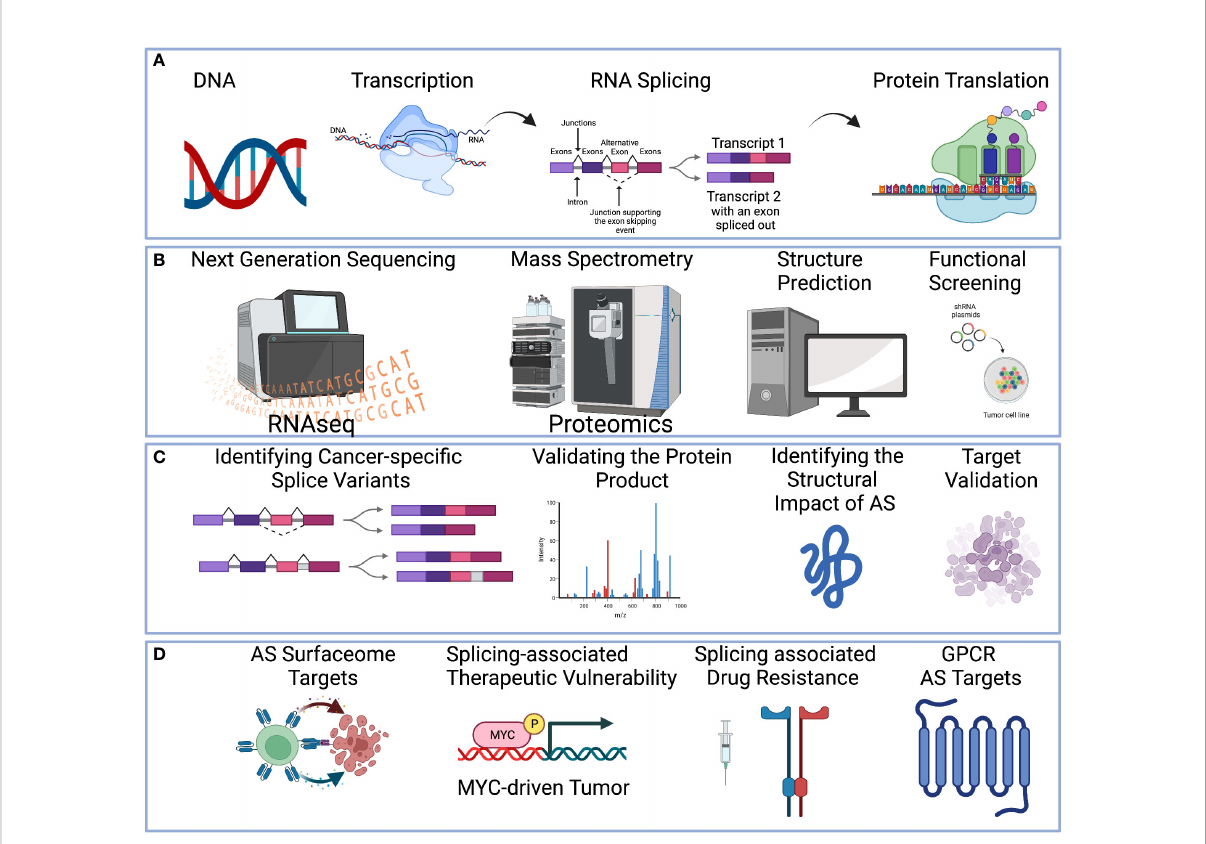
FIGURE 1 A holistic multi-omics approach to understanding therapeutic targets in cancer. (A) Central dogma of DNA-to-RNA followed by RNA splicing and protein translation. (B) Multi-omics technologies can be applied to study alternative splicing events, including High-throughput sequencing to pro fi le the RNA transcript (Left-Most). Mass spectrometry technologies to pro fi le the protein (Middle-Left). Protein structure can be predicted (Middle-Right). Functional screening such as siRNA or CRISPR can be applied (Right-Most). (C) RNA sequencing technologies can reveal the alternative splicing pattern (Left-Most). Mass spectrometry technologies can validate the protein product (Middle-Left). Structure prediction can identify the impact of alternative splicing (Middle-Right). Functional screening with oligonucleotide or CRISPR to screen for the functional effect of the target (Right-Most). (D) Examples of therapeutic strategies to target alternative splicing include splicing-derived neoantigens for immunotherapy, splicing-associated therapeutic vulnerability, splicing factor inhibitors, and small molecular inhibition to overcome drug resistance. Created with